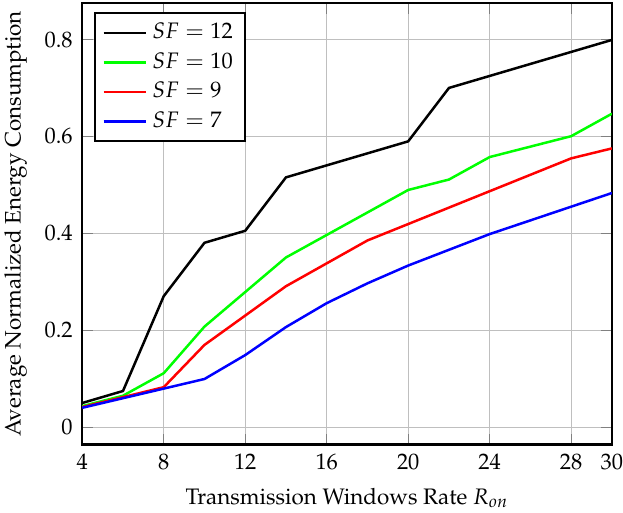
Figure 11. Average and worst-case number of received packets of different SF and R on values at speed = 80 km/h for semisynchronized transmission.